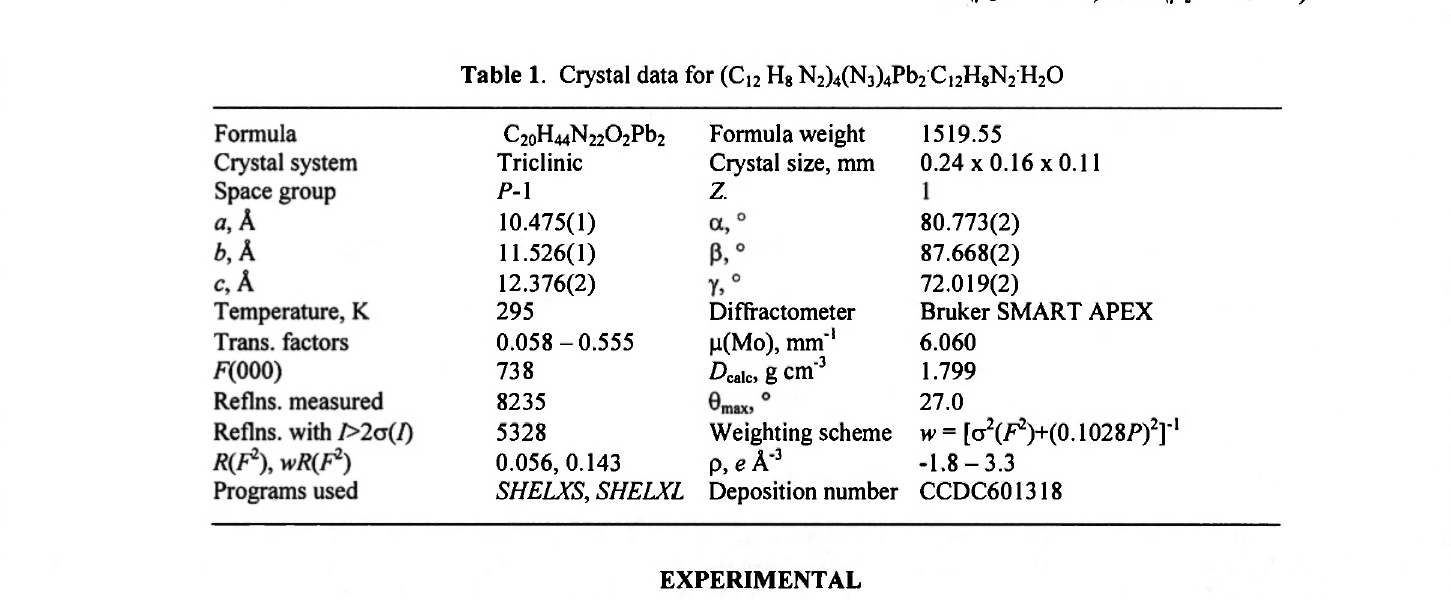
Table 1. Crystal data for (C 12 H s Ν 2 ) 4 (Ν 3 ) 4 Ρ^€ 12 Η 8 Ν 2 Ή 2 0